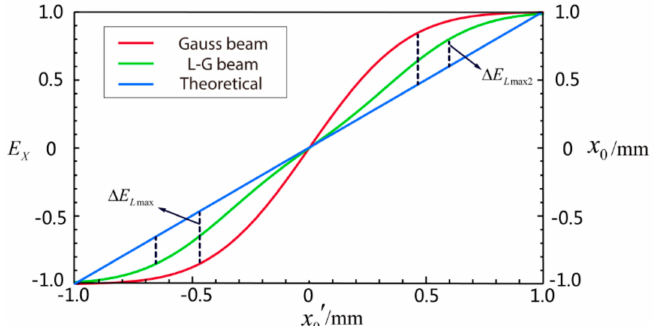
Figure 4. The simulation curves of estimation in the measurement range from − 1 mm to 1 mm; the blue line represents the theoretical estimation; the red curve is the estimation of Gauss beam by simulation; and the green curve is the estimation of L-G beam by simulation.